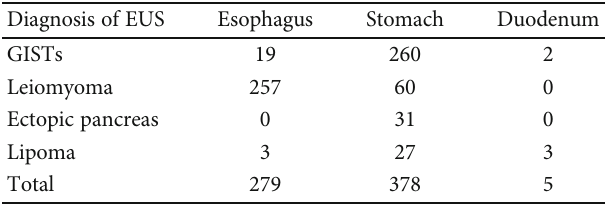
Table 5: Grayscale histogram analysis of GIST and leiomyoma. The mean gray